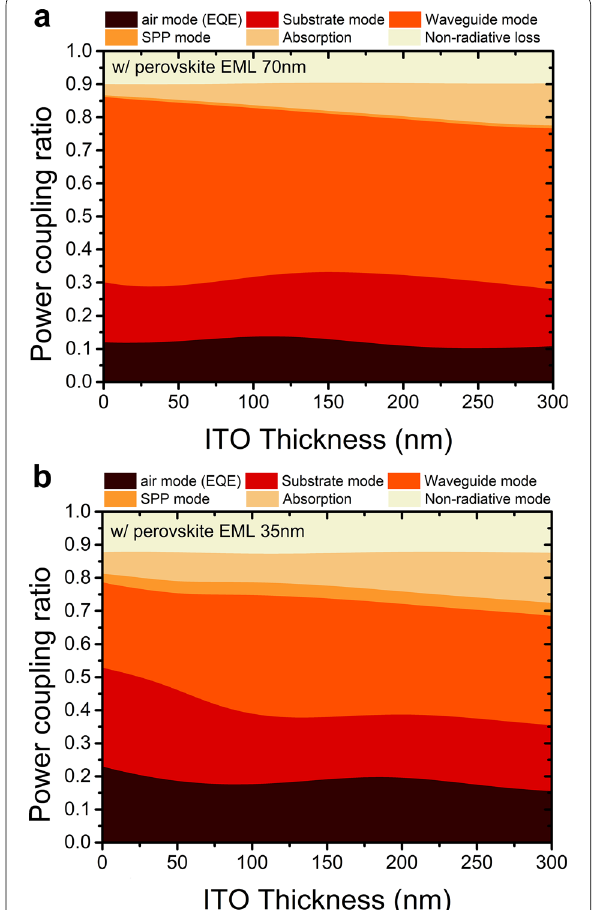
Fig. 3 Optical power distributions for different ITO thickness with fixed thicknesses of the perovskite EML of a 70 nm and of b 35 nm